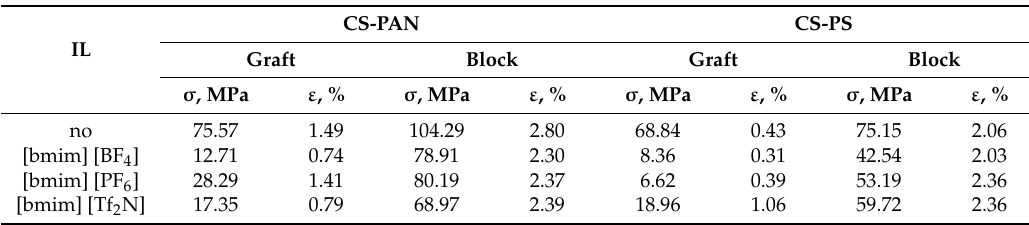
Table 2. The mechanical properties of the obtained